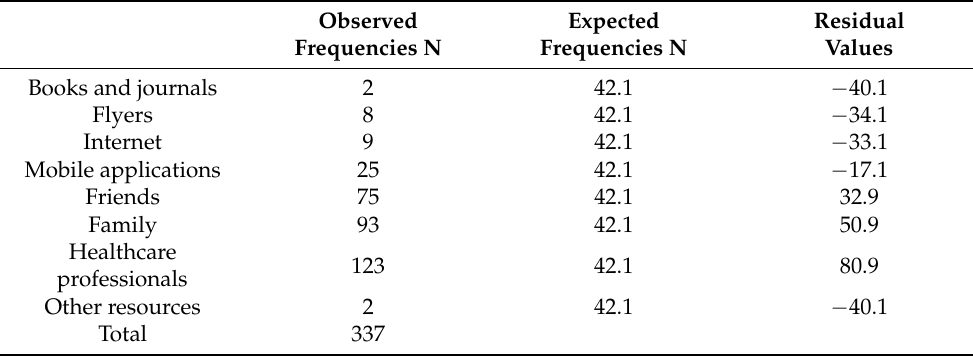
Observed Expected Frequencies N Frequencies N